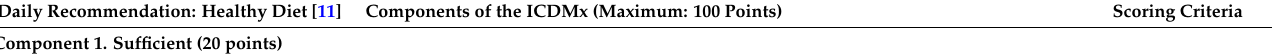
Table 1. ICDMx components and their relationship to the key recommendations of the daily dietary guide (unit/day) for the Mexican population (maximum: 100 points). Daily Recommendation: Healthy Diet [11] Components of the ICDMx (Maximum: 100